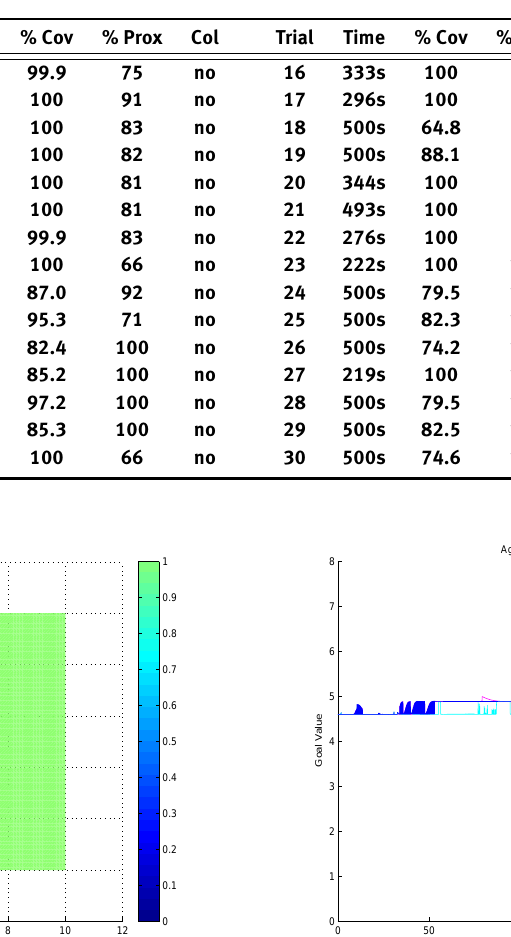
Table 4. Table of simulation performance metrics.